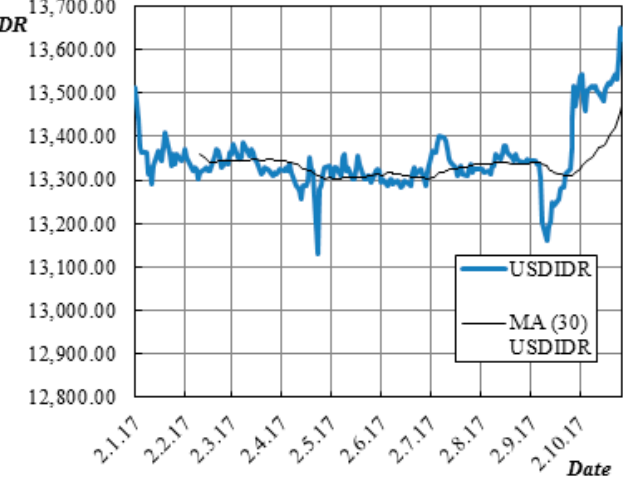
Figure 6. Development of Indonesian rupiah (IDR) vs. United States dollar (USD) rate (1 = January 2017).